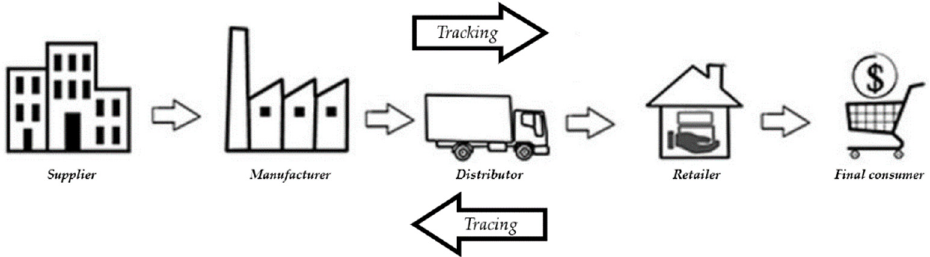
Figure 1. Representation of the tracking and tracing approach (GS1, 2017).